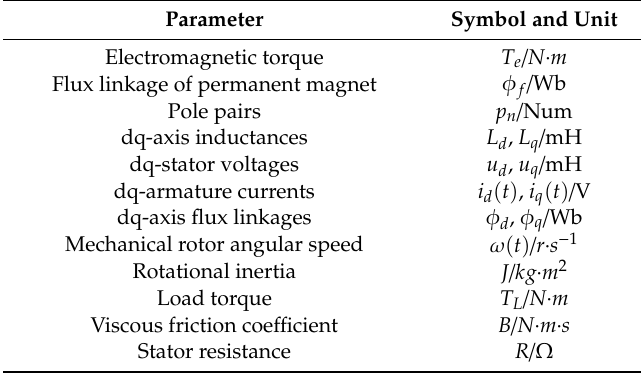
Table 1. Parameters of the permanent magnet synchronous motor